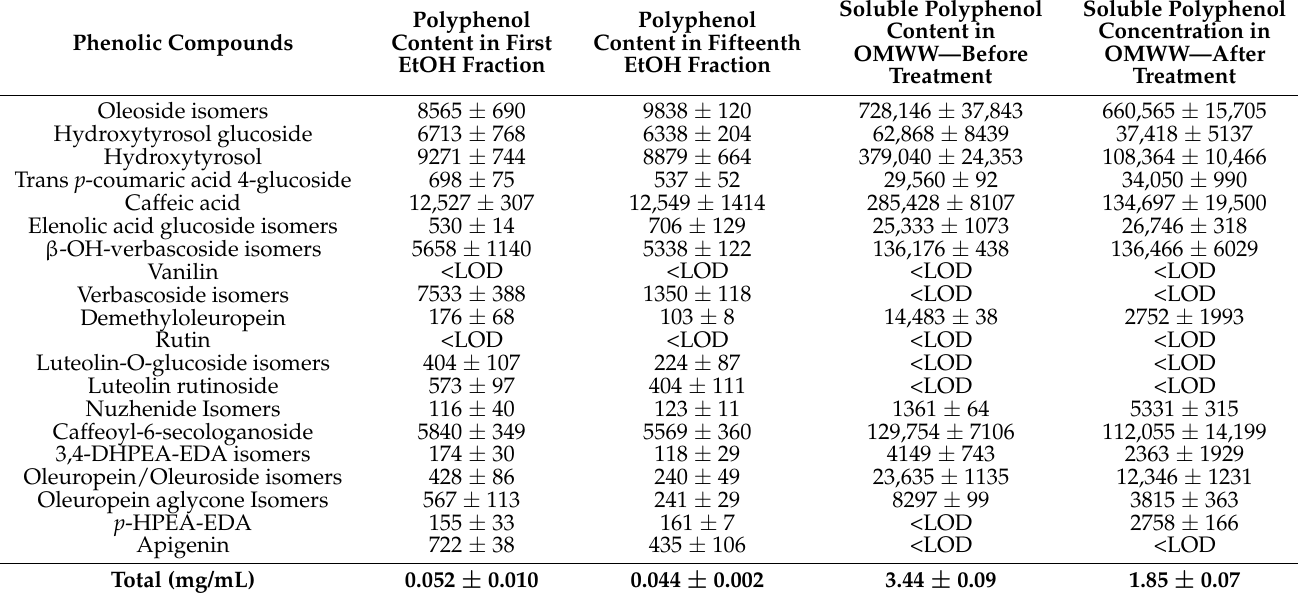
Table 2. Polyphenol quantities for fifteen subsequent treatments of olive mill waste water (OMWW) with unmodified Fe 3 O 4 particles. The particles were thereafter desorbed in ethanol (EtOH). The total concentration of polyphenolic compounds is quantified in mg per mL of OMWW; individual compounds are semi-quantified (using counts from the mass spectrometer (MS)